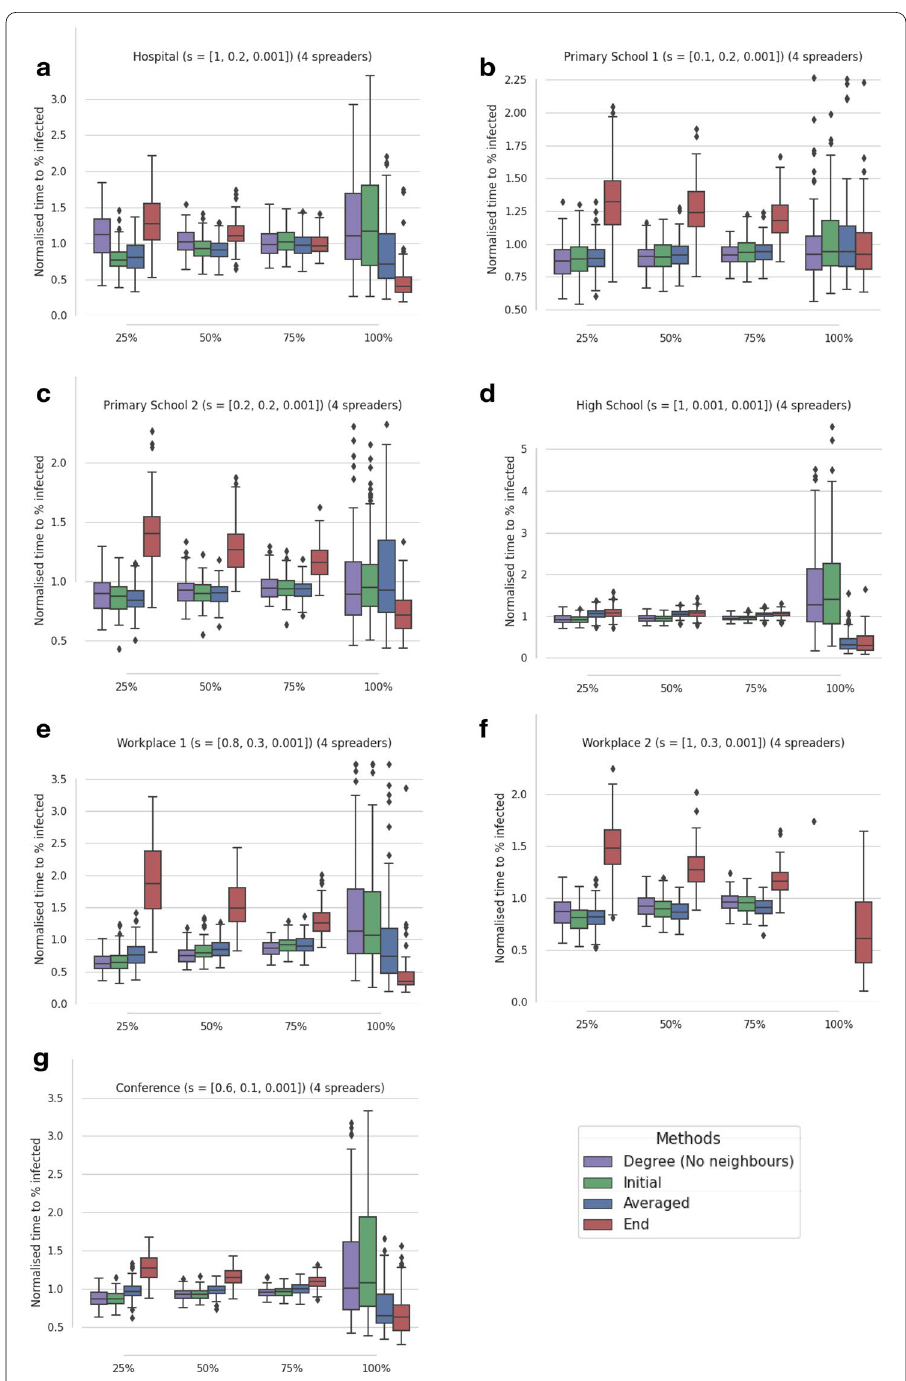
Fig. 3 Results from SI simulations ( τ = 1 ) of real-world contact networks using four selected spreaders. The contact networks are, a a hospital ward (Vanhems et al. 2013), b , c , a primary school (Stehlé et al. 2011), d a high school (Salathé et al. 2010), e , f a workplace (Génois et al. 2015; Génois and Barrat 2018) and, g a conference (Génois and Barrat 2018). Times are recorded from 100 SI simulations when 25%, 50%, 75%, and 100% of network are infected and then normalised with the mean of all times recorded at each percentage. From left to right; times are detailed for the weighted degree (no neighbours) selection, then the eigenvector-based selections for initial rate (Initial), average performance (Averaged), and time to all infected (End). The y-axes of a , c , f , g are cropped to exclude extreme